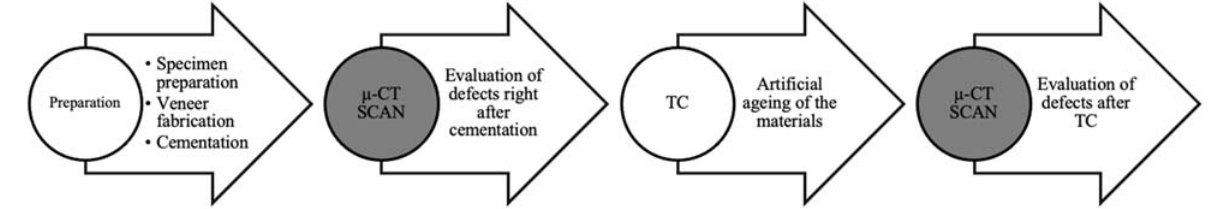
Figure 5. Data collection steps. TC = thermocycling.